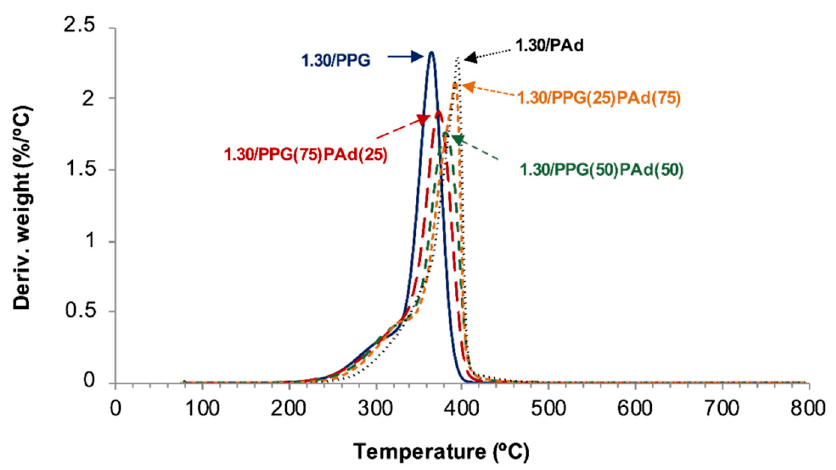
Figure A2. X-ray diffractogram of PAd polyol. Polymers 2021 , 13 , x FOR PEER REVIEW